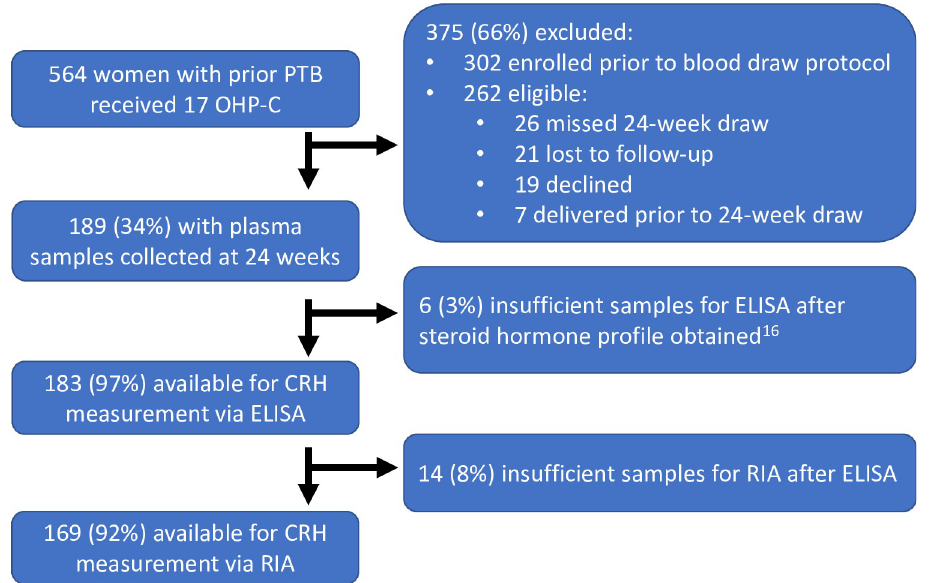
Fig 2. Study flow diagram. 17 OHP-C = 17-alpha hydroxyprogesterone caproate, ELISA = enzyme-linked immunosorbent assay, RIA = radioimmunoassay.